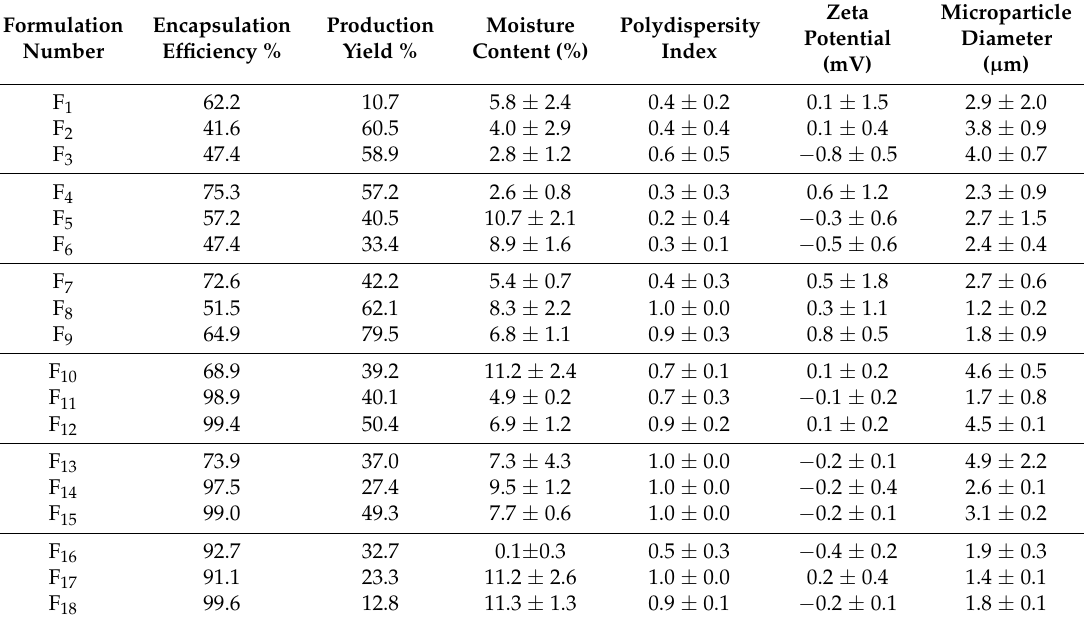
Table 4. Characteristic of obtained microparticles (F 1 –F 18